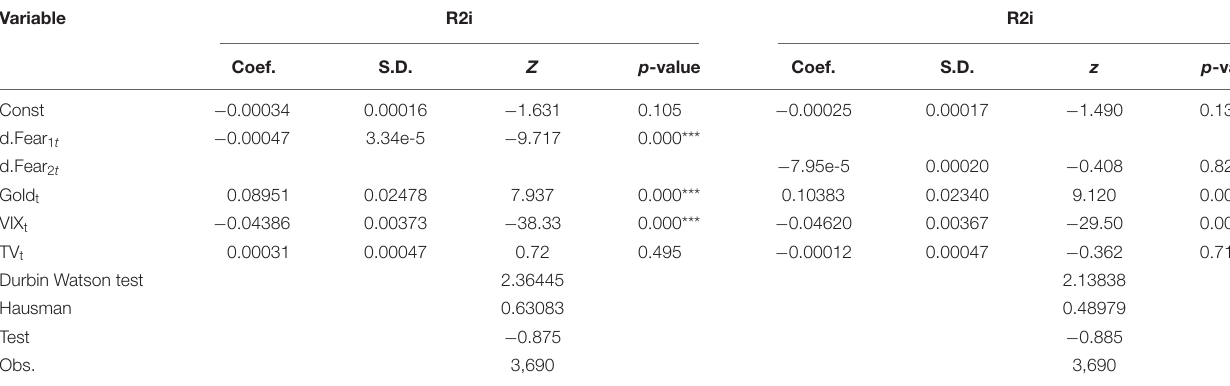
***indicate the significance at 1, 5, and 10% levels,